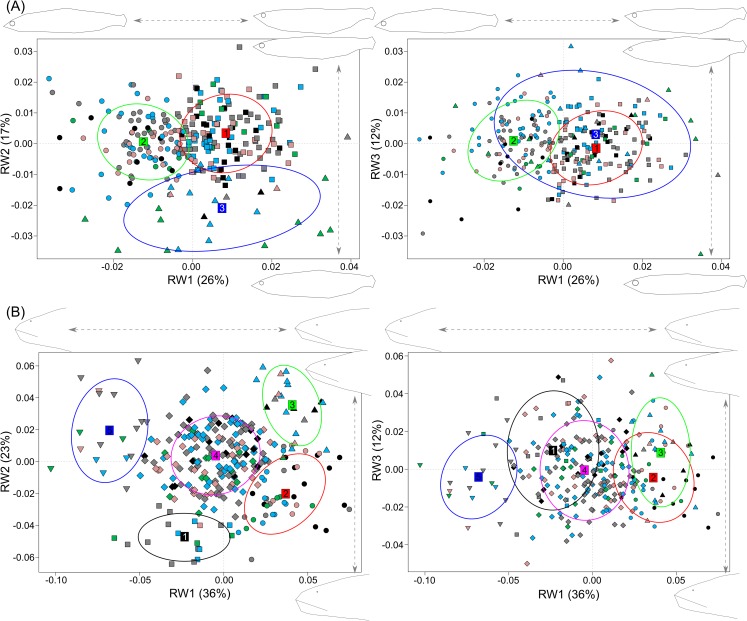
Association between morphological clusters and genetically-differentiated clusters of lake trout present in Mistassini Lake.Morphological clusters are identified by symbol shape and ellipses which represent 67% of that cluster’s variation and genetically-differentiated clusters are identified by symbol colour. (A) RW1 vs. 2 and 1 vs. 3 (55%) of body shape variation. Morphological shifts for RW1 (26%) correspond to the slope of the snout, lower jaw and dorsal and belly curvature; RW2 (17%) correspond to slope of top of cranium and dorsal side, length and depth of caudal peduncle; RW3 (12%) correspond to body depth, eye position and size. (B) RW 1 vs. 2 and 1 vs. 3 (71%) of head shape variation. Morphological shifts for RW1 (36%) correspond to length of head and snout, eye position and length of upper jaw; RW2 (23%) correspond to head depth and bluntness of snout; RW3 (12%) correspond to slope of lower and upper jaw. Inset images are visualizations of the shape at the most extreme end of each relative warp.